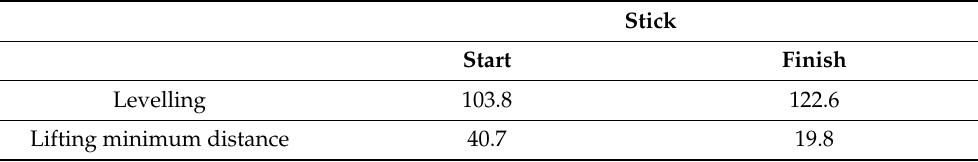
Table 6. Start and end stresses [MPa] for the stick during the phase change.